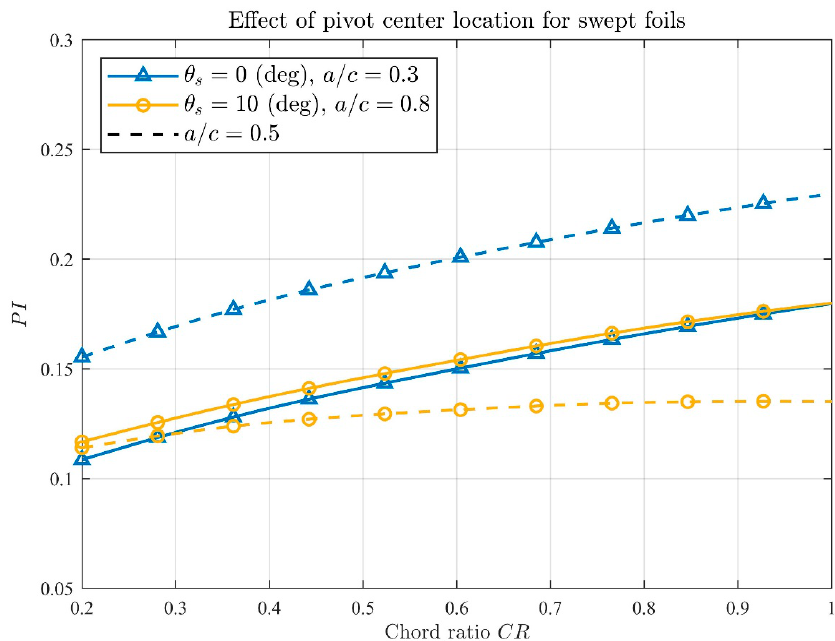
Figure 11. E ff ect of the pivot axis location on the performance of the swept foil. Continuous line: a / c = x P ( θ S ) / c , dashed line: a / c = 0.5.